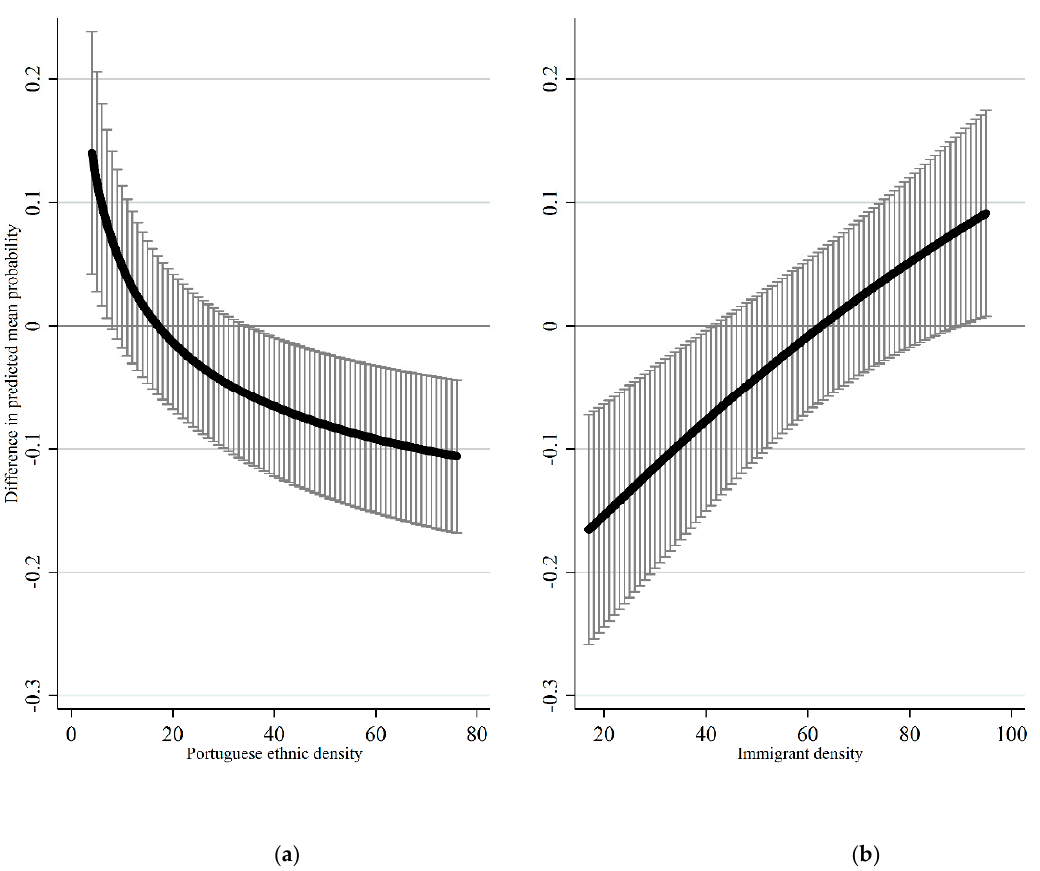
Figure 2. ( a ) Average marginal effect of being of Portuguese descent by Portuguese ethnic density in school-class with 95% confidence intervals; ( b ) average marginal effect of being of Portuguese descent by immigrant density in school-class with 95% confidence intervals. Reference category: Native. Note all other variables are held at their observed values in the data.